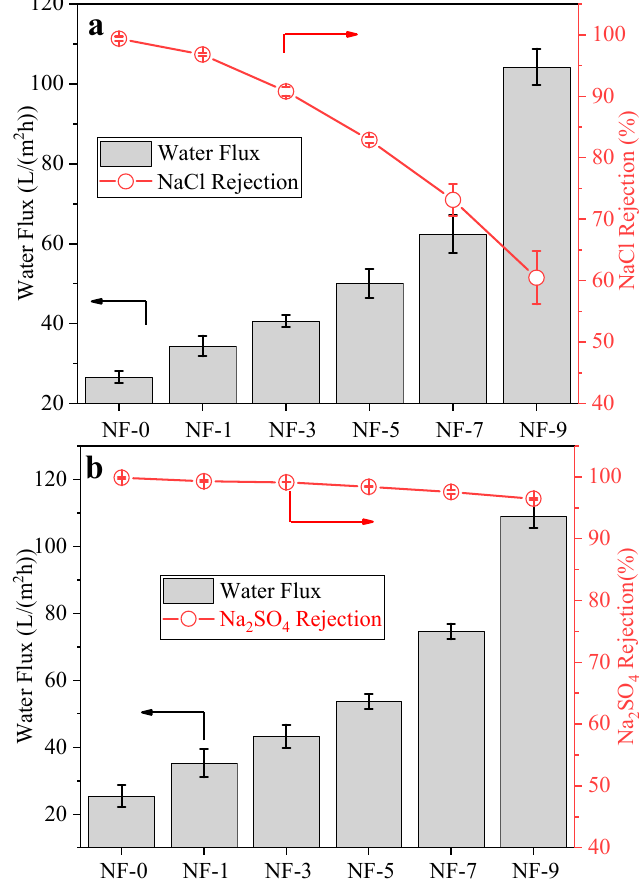
Figure 8. Water flux and rejection of ( a ) NaCl/( b ) Na 2 SO 4 with different DWCNT dosages.